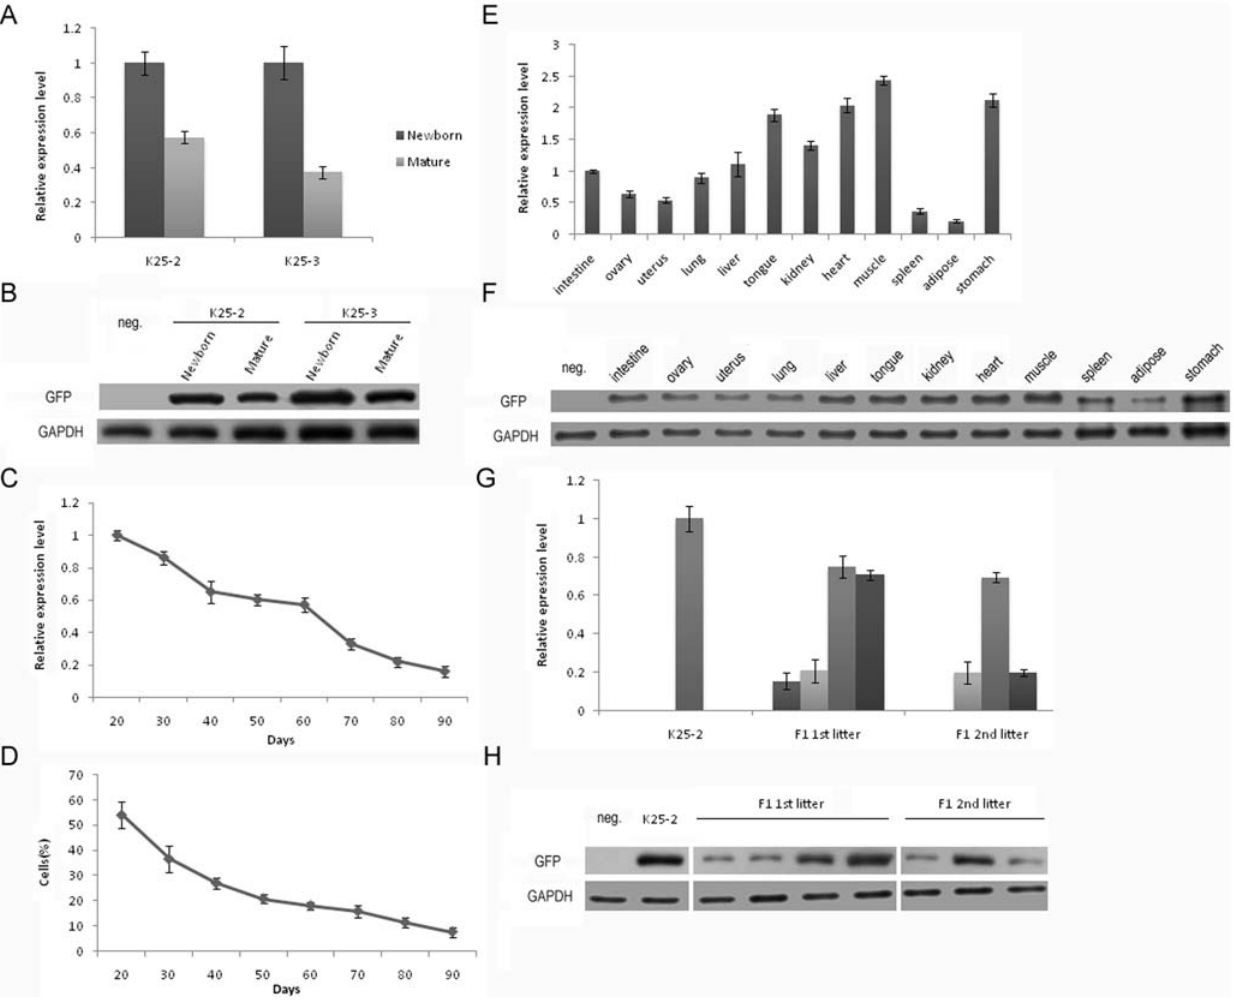
Figure 1. Expression of GFP. (A) Relative real-time RT-PCR analysis of GFP mRNA expression from newborn to maturity in founder transgenic pigs. The decline was significant in both K25-2 and K25-3 (p , 0.001); (B) Western blots analysis of GFP protein from newborn to maturity in founder transgenic pigs; (C) Relative real-time RT-PCR analysis of GFP mRNA expression in transgenic fibroblast cells. The decline of mRNA from 20 to 90 days was significant (p , 0.001); (D) Flow cytometry analysis of the percentage of phenotype positive cells. The decline of percentage of positive cells from 20 to 90 days was also significant (p , 0.001); (E) Relative real-time RT-PCR analysis of GFP mRNA expression in various tissues of the transgenic pig. Variegation of GFP mRNA expression was shown in different tissues (p , 0.001); (F) Western blots analysis of GFP protein in various tissues; (G) Relative real-time RT-PCR analysis of GFP mRNA expression in offspring transgenic pigs. The decline from founder to offspring was significant (p , 0.001); (H) Western blots analysis of GFP protein in offspring transgenic pigs. Error bars denote standard deviations. Neg., non-transgenic